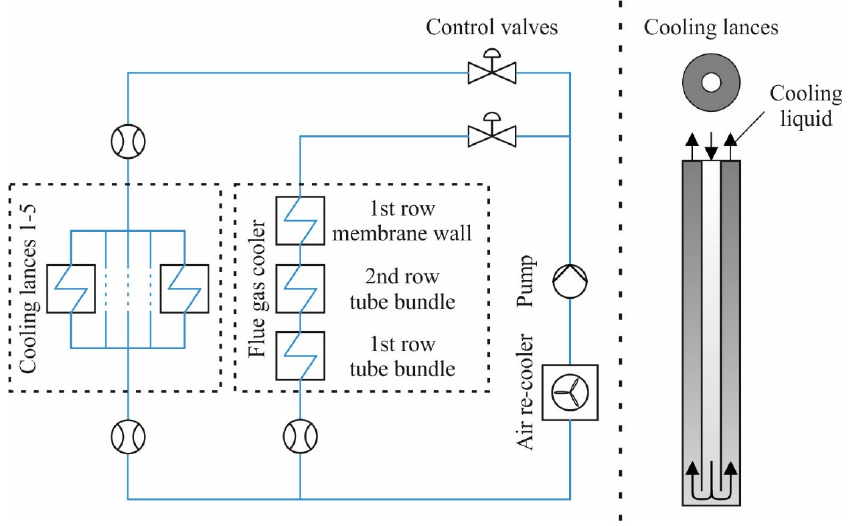
Figure 2. Flow diagram of cooling system (cold side) and scheme of cooling lances. Table 2. Dimensions and boundary conditions of the heat exchangers.